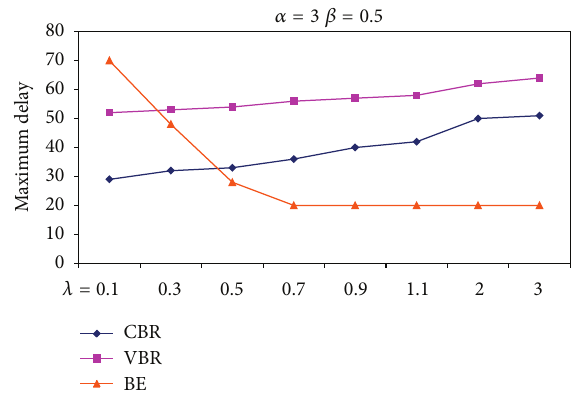
Figure 10: Maximum delay suffered for different values of 𝜆 when 𝛼 and 𝛽 are kept constant.